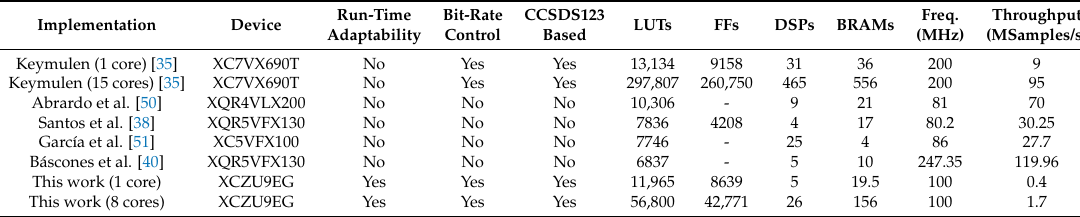
Table 6. Comparison with other Field-Programmable Gate Array (FPGA) implementations of lossy compression